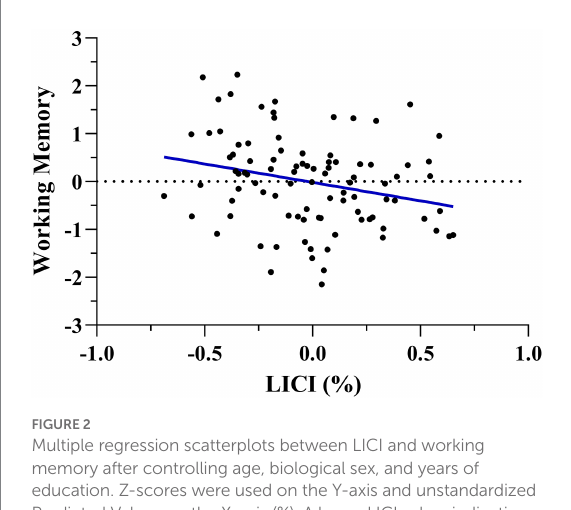
FIGURE 2 Multiple regression scatterplots between LICI and working memory after controlling age, biological sex, and years of education. Z-scores were used on the Y-axis and unstandardized Predicted Values on the X-axis (%). A lower LICI value, indicative of more intracortical motor inhibition, was related to better working memory performance.